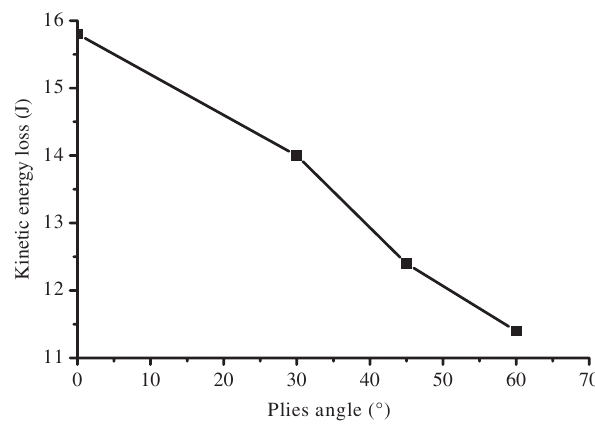
Figure 6: Bullet kinetic energy-time curves with different layer angles.